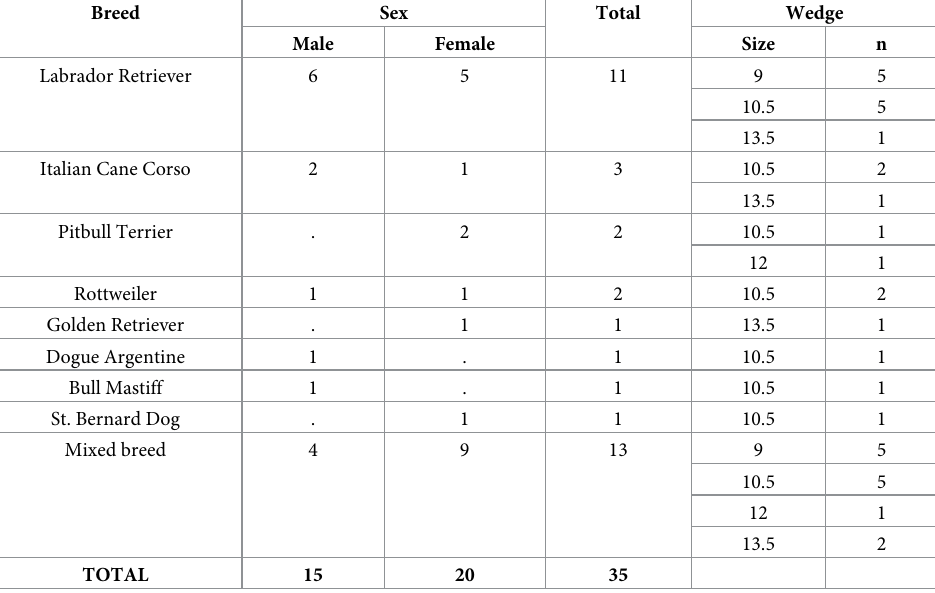
Table 1. Distribution of study population for breed, sex and wedge size. Breed